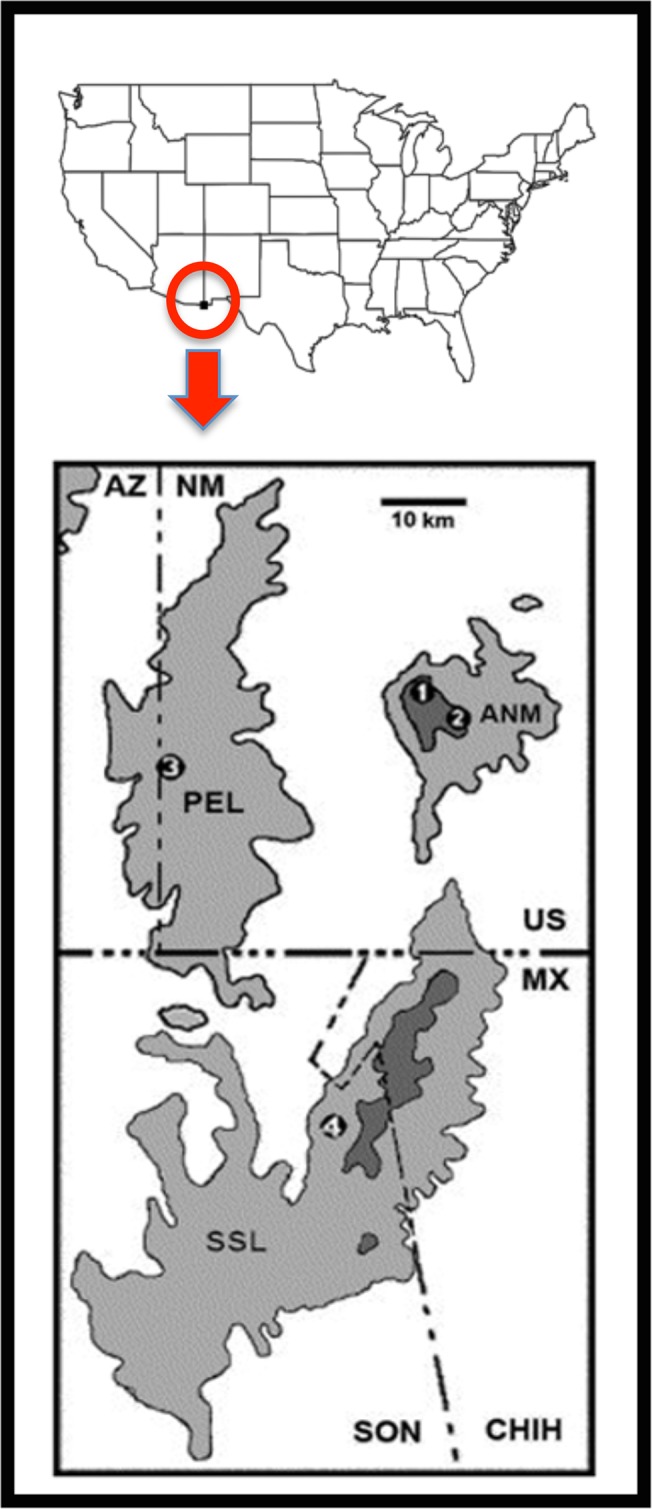
Distribution of Crotalus willardi obscurus in North American (top picture), and magnified into a perspective of the three sky-islands in southwestern North America (bottom picture) that straddle southeastern Arizona (AZ), southwestern New Mexio (NM), and north-central México (MX).PEL = Peloncillos Mountains (AZ); ANM = Animas Mountains (NM); SSL = Sierra San Luis Mountains (México). Numbers indicate specific locations of study sites, two of which are within Animas Mountains: (1) = West Fork Canyon (ANM-W); (2) = Indian Creek (ANM-I); (3) = Peloncillos Mountain; (4) = Sierra San Luis Mountain.